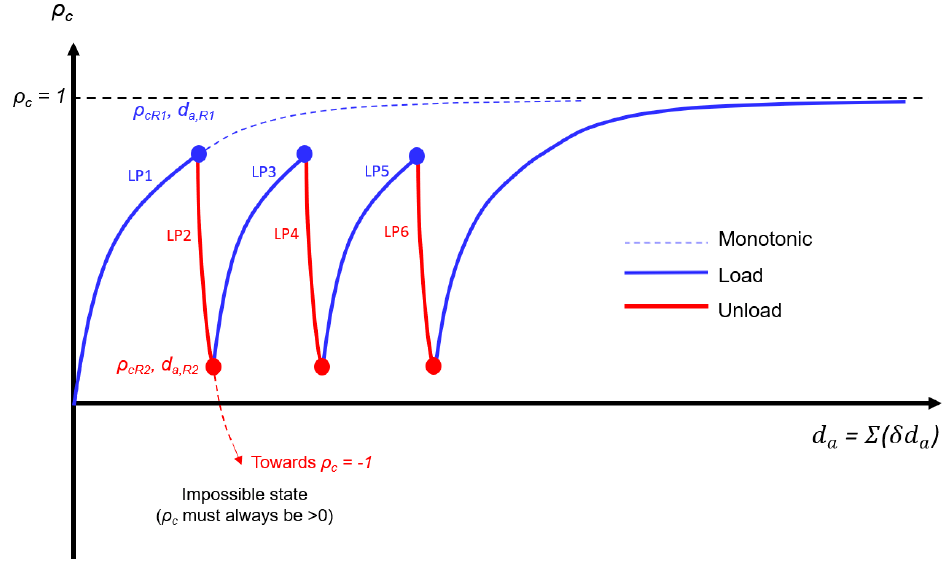
Figure 4. Representation of the hardening term ρ c under unloading–reloading behaviour.